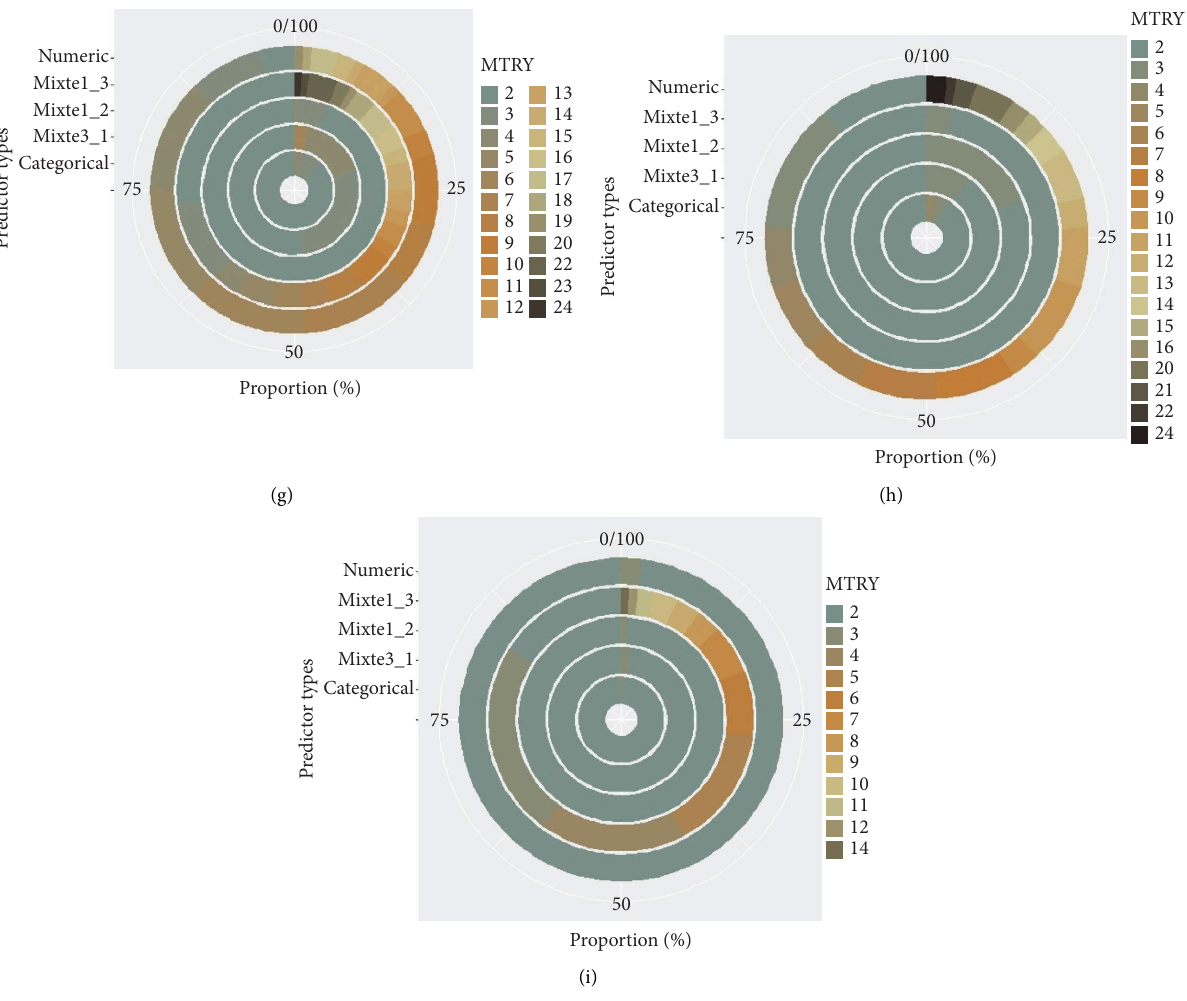
Figure 2: Best RF mtry as a function of the population size, number, and type of predictors (Numeric � 100% are quantitative predictors, Mix t 1 3 � 25% are quantitative predictors, Mix t 1 2 � 50% are quantitative predictors, Mix t 3 1 � 75% are quantitative predictors, and Categorical � 100% are categorical predictors). (a) N � 50 , P � 8, (b) N � 250 ,P � 8, (c) N � 1250 ,P � 8, (d) N � 50 , P � 16, (e) N